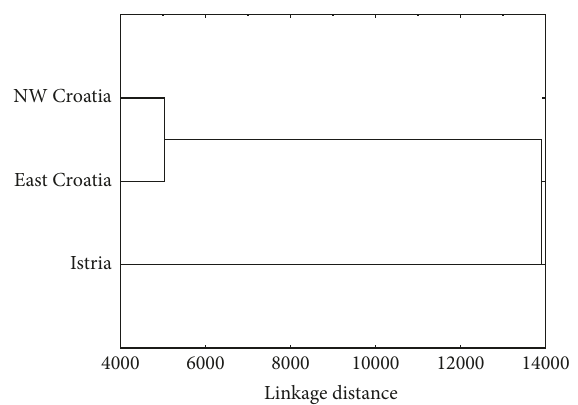
Figure 2: Dissimilarities between the three types of honey in Croatia, according to the analyzed parameters and regions.